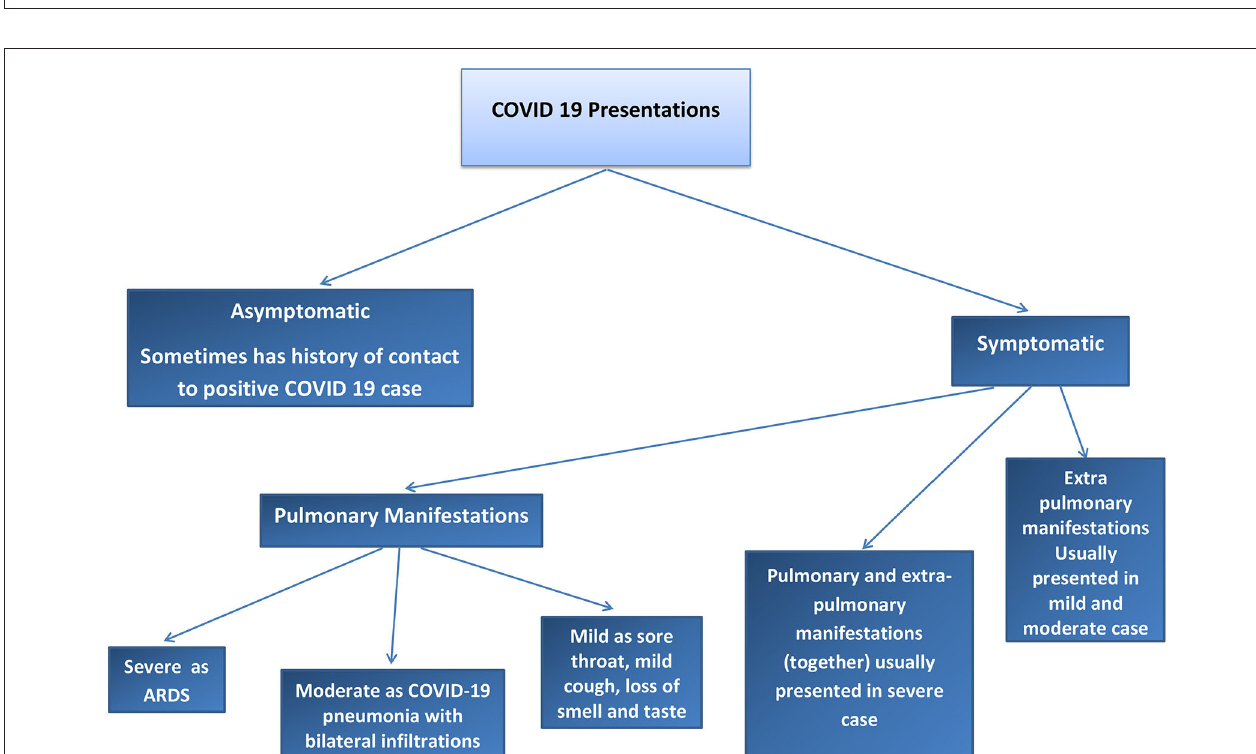
FIGURE 2 | Diagram to explain the COVID-19 presentations in Health care provider